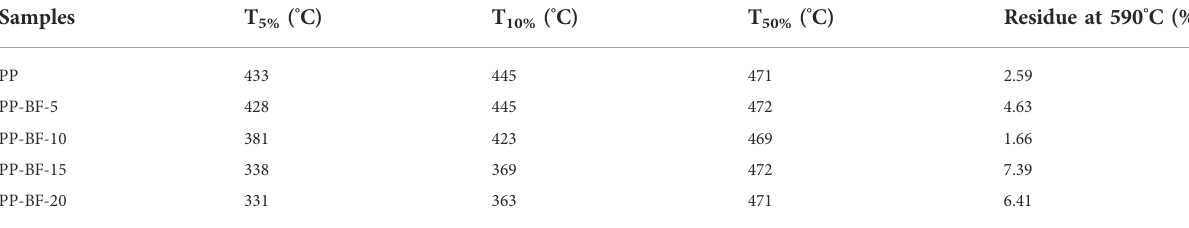
TABLE 1 Temperatures at 5, 10 and 50% weight loss of the samples and residue (%) at 590 ° C obtained from TGA.